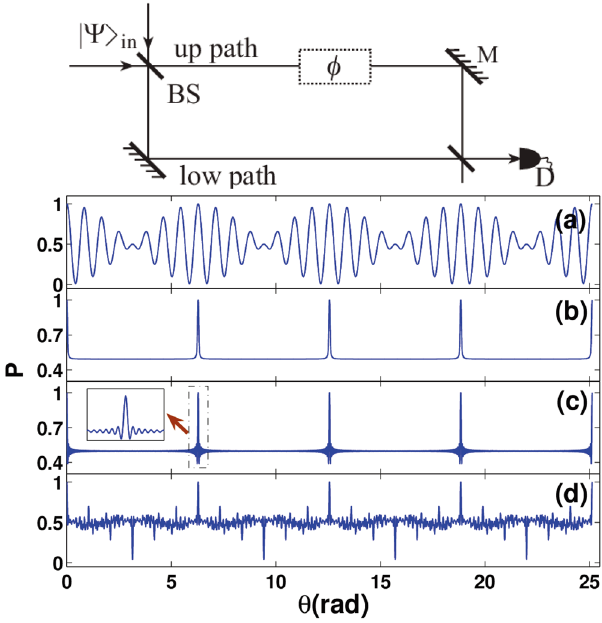
Figure 1. The probability P to get the photon by a detector on an output of the interferometer. ( a ) The result for an equivalent mode L composed of equal weighted superposition of l composed of eigen modes from 1 to 100 with weighting factors = − c p 101 composed of equal weighted OAM eigenmodes from 1 to 100. The inset is the magnification of the box area. ( d ) The result for a mode composed of all prime number modes between 1 and 100 with equal weight. Scheme to test NOON states is shown on top of the figure. Ψ BS: beam splitter; M: